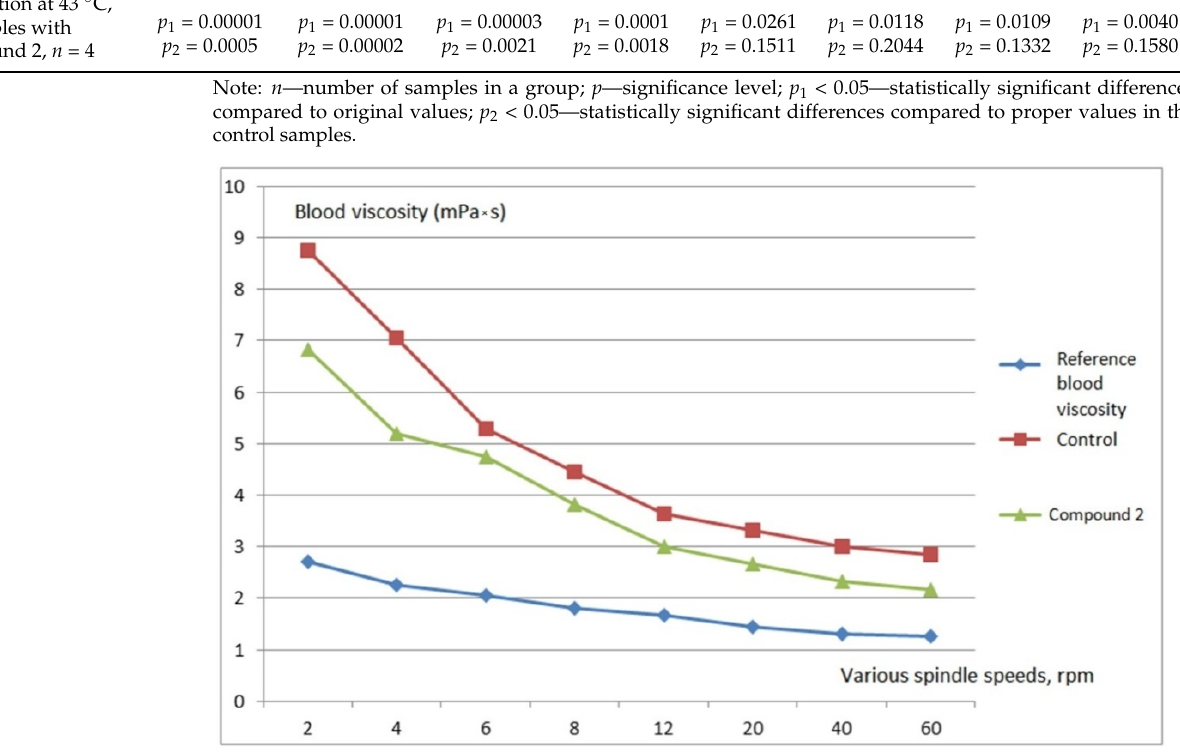
Figure 4. The hemorheological activity of compound 2.